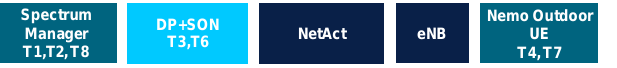
Figure 9. The LSAevo Spectrum Manager performance measurement set up.